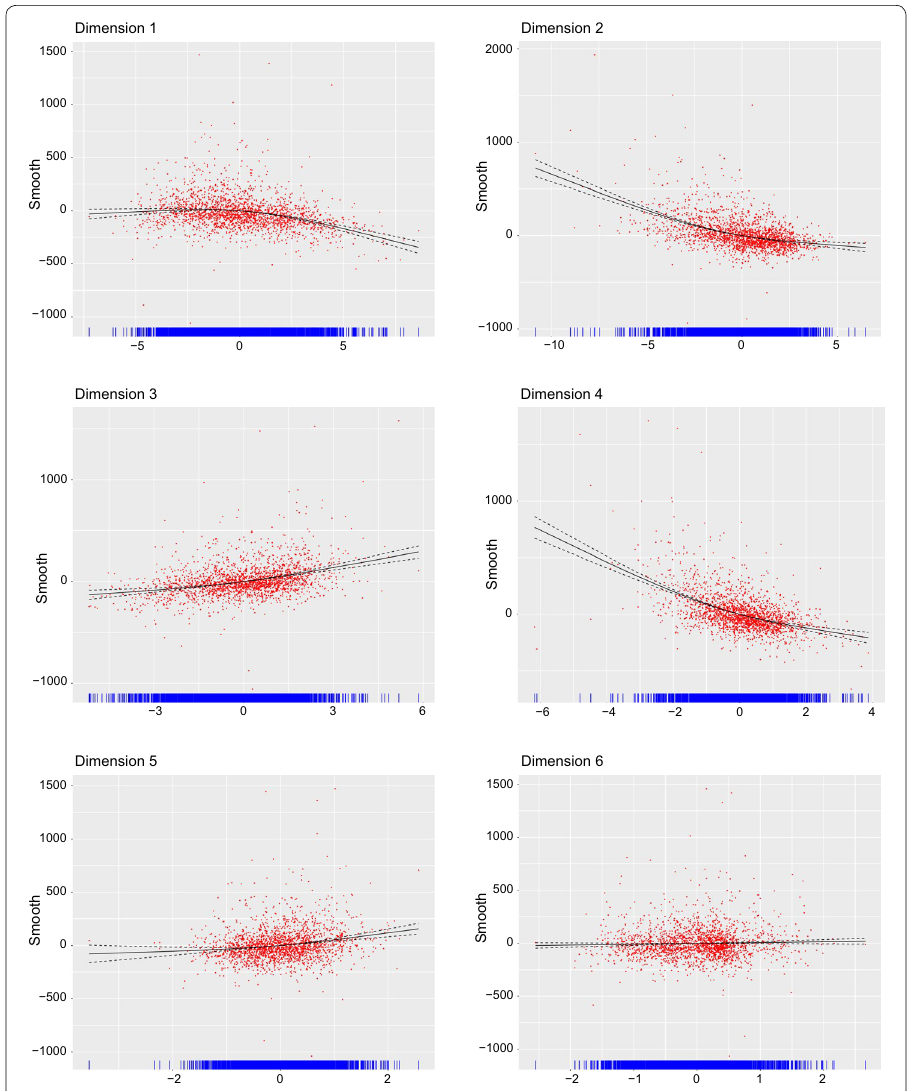
Fig. 2 Partial residual plots for each of the PCA predictors when Y 1 is the